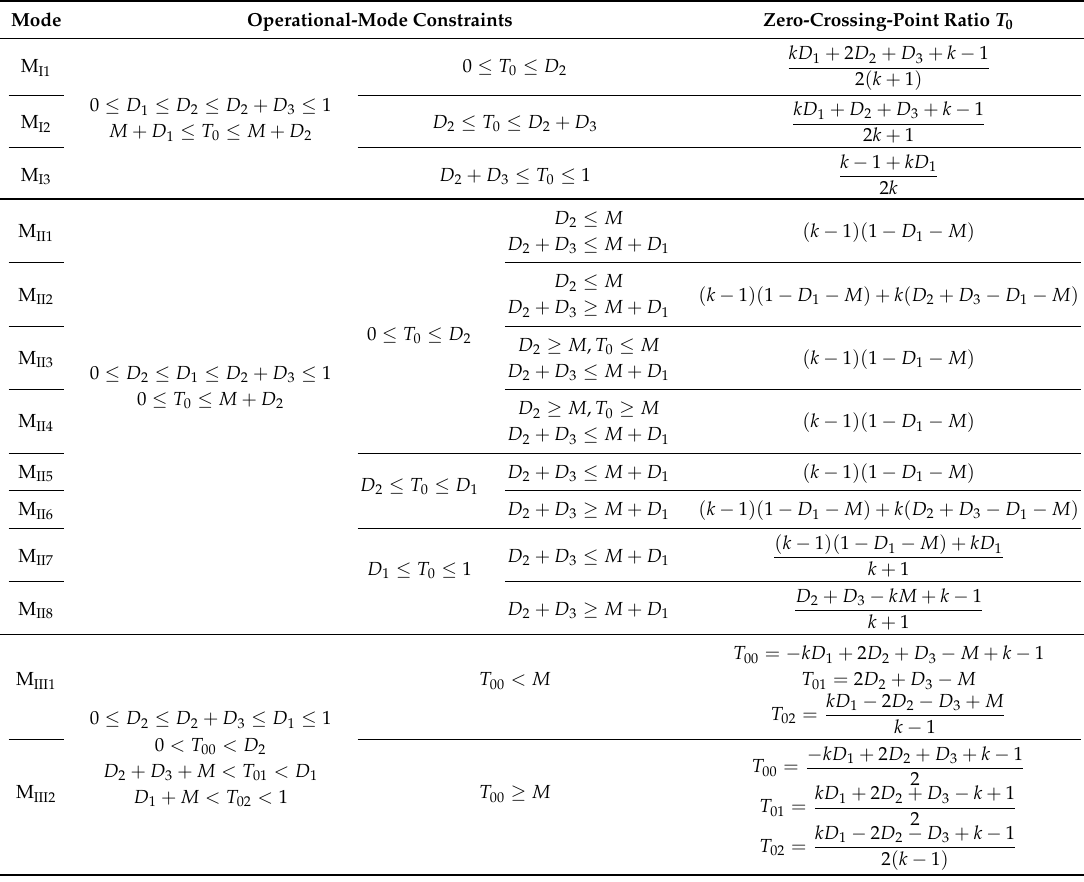
Figure 9. Waveforms of sub modes under M III : ( a ) M III1 ; and ( b ) M III2 . Table 1. Operational-Mode Constraints of DAB